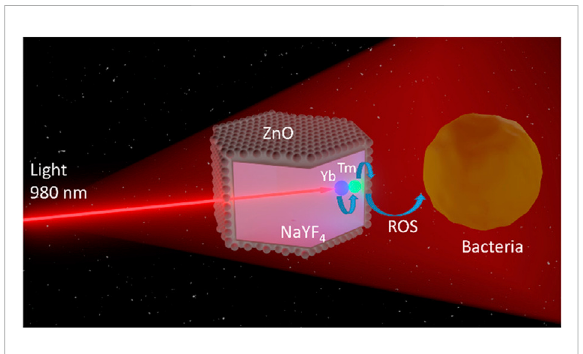
FIGURE 3 The dopant Yb 3+ and Tm 3+ ions convert 980 nm of NIR light into UVlight.The ZnOintheouterlayerofthecore-shell structure absorbs UV light to produce ROS and achieve the antibacterial effect (Karami et al.,